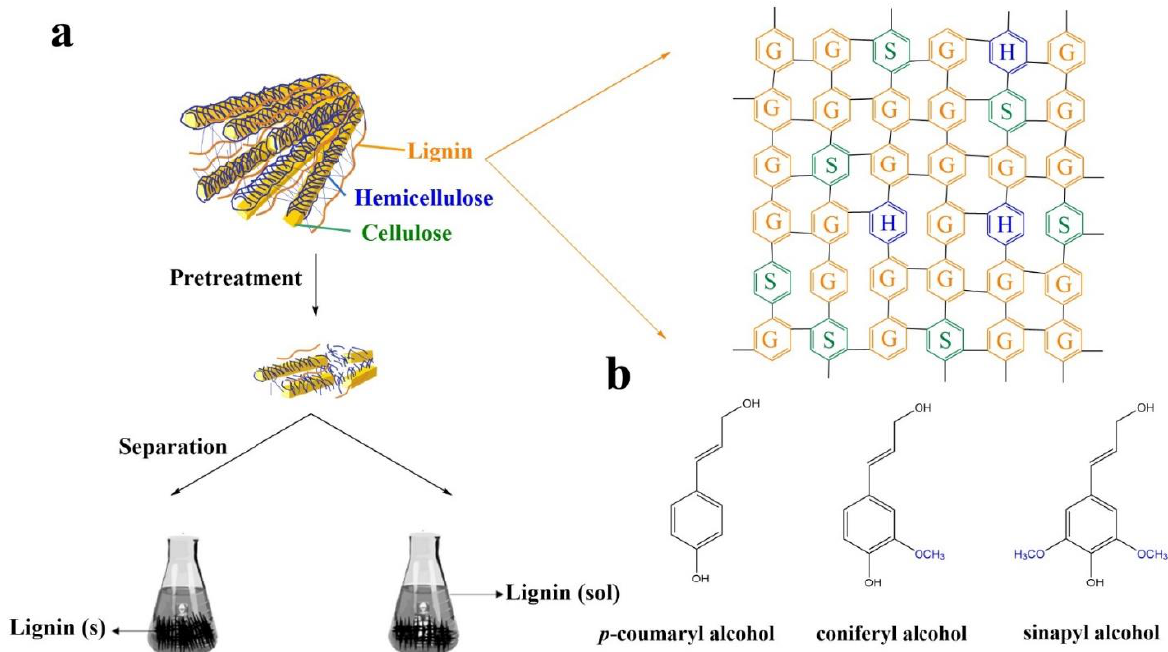
Figure 1. The structural formula and extraction methods of lignin. Lignin is a category of polymers composed of phenolic subunits, with three monolignols connected by ether bonds and carbon–carbon bonds. This figure gives a representative model for part of the structure of lignin. The circumjacent monolignols are linked with minolignols that are not displayed in the figure. Lignin is separated from lignocellulosic materials using two different strategies, making the lignin stay in the precipitate or enter the liquid phase (shows in ‘’s’’ and ‘’sol’’ ) ( a ). The p -coumaryl, coniferyl and sinapyl alcohols are the three monolignols found in lignin ( b ).